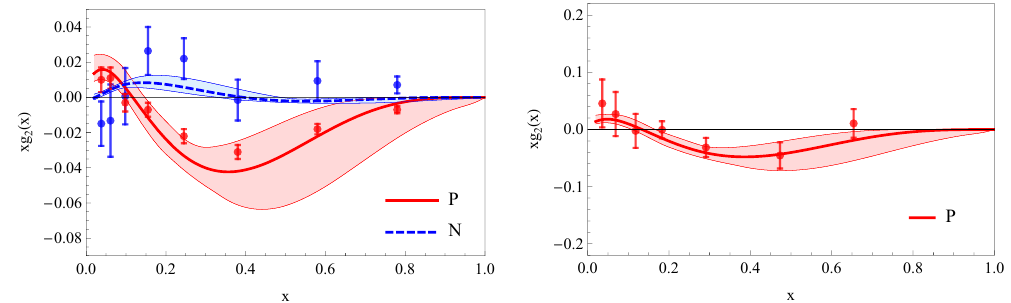
Figure 2. Left panel: the structure function xg 2 ( x ) in WW-approximation at Q 2 = 7 : 1 GeV 2 , eq. (3.9), for proton (P) and neutron (N) targets, and data from the SLAC E144 and E155 ex- periments at h Q 2 i = 7 : 1 GeV 2 [23, 24]. Right panel: HERMES data for Q 2 > 1 GeV 2 with h Q 2 i = 2 : 4 GeV 2 [25]. The estimate of the theoretical uncertainty is described in the